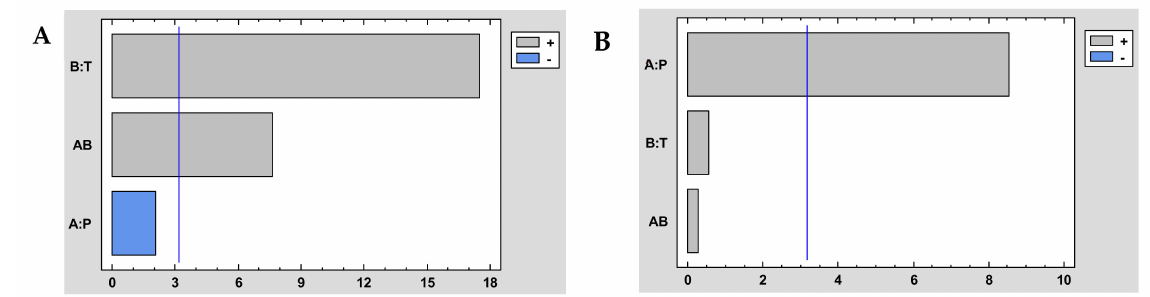
Figure 4. Pareto chart of impregnation yield ( A ) and antioxidant loading ( B ) of dressings at different conditions of the impregnation of A. muricata leaf extract into NaCMC. Tempertuare (T) and pressure